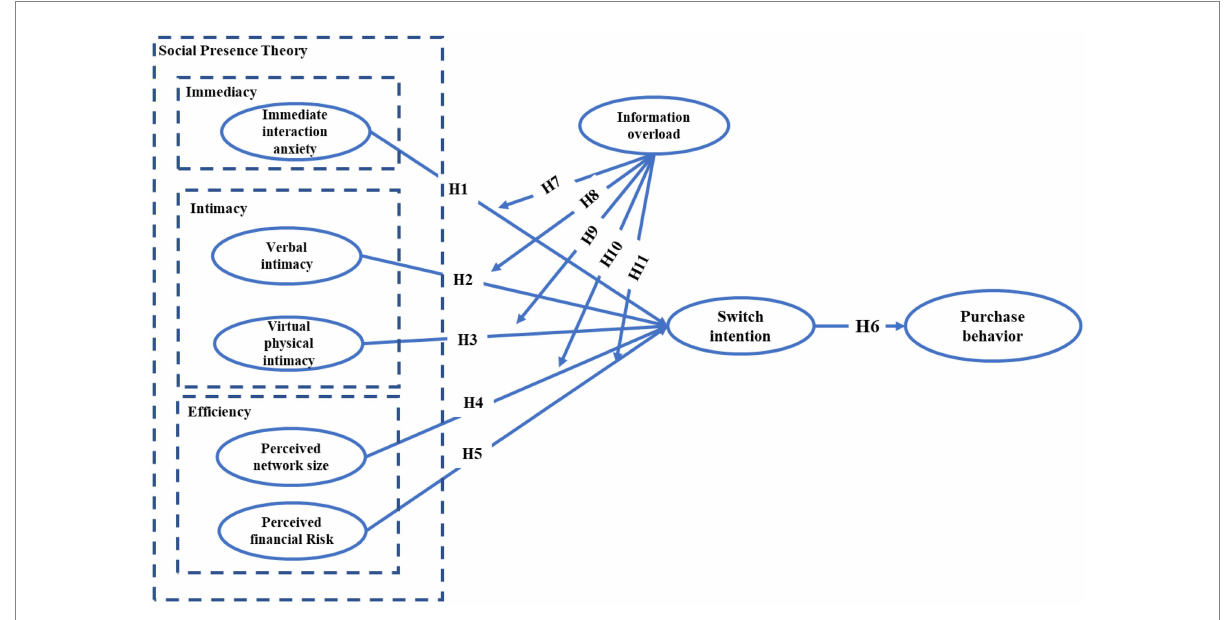
FIGURE 1 Research